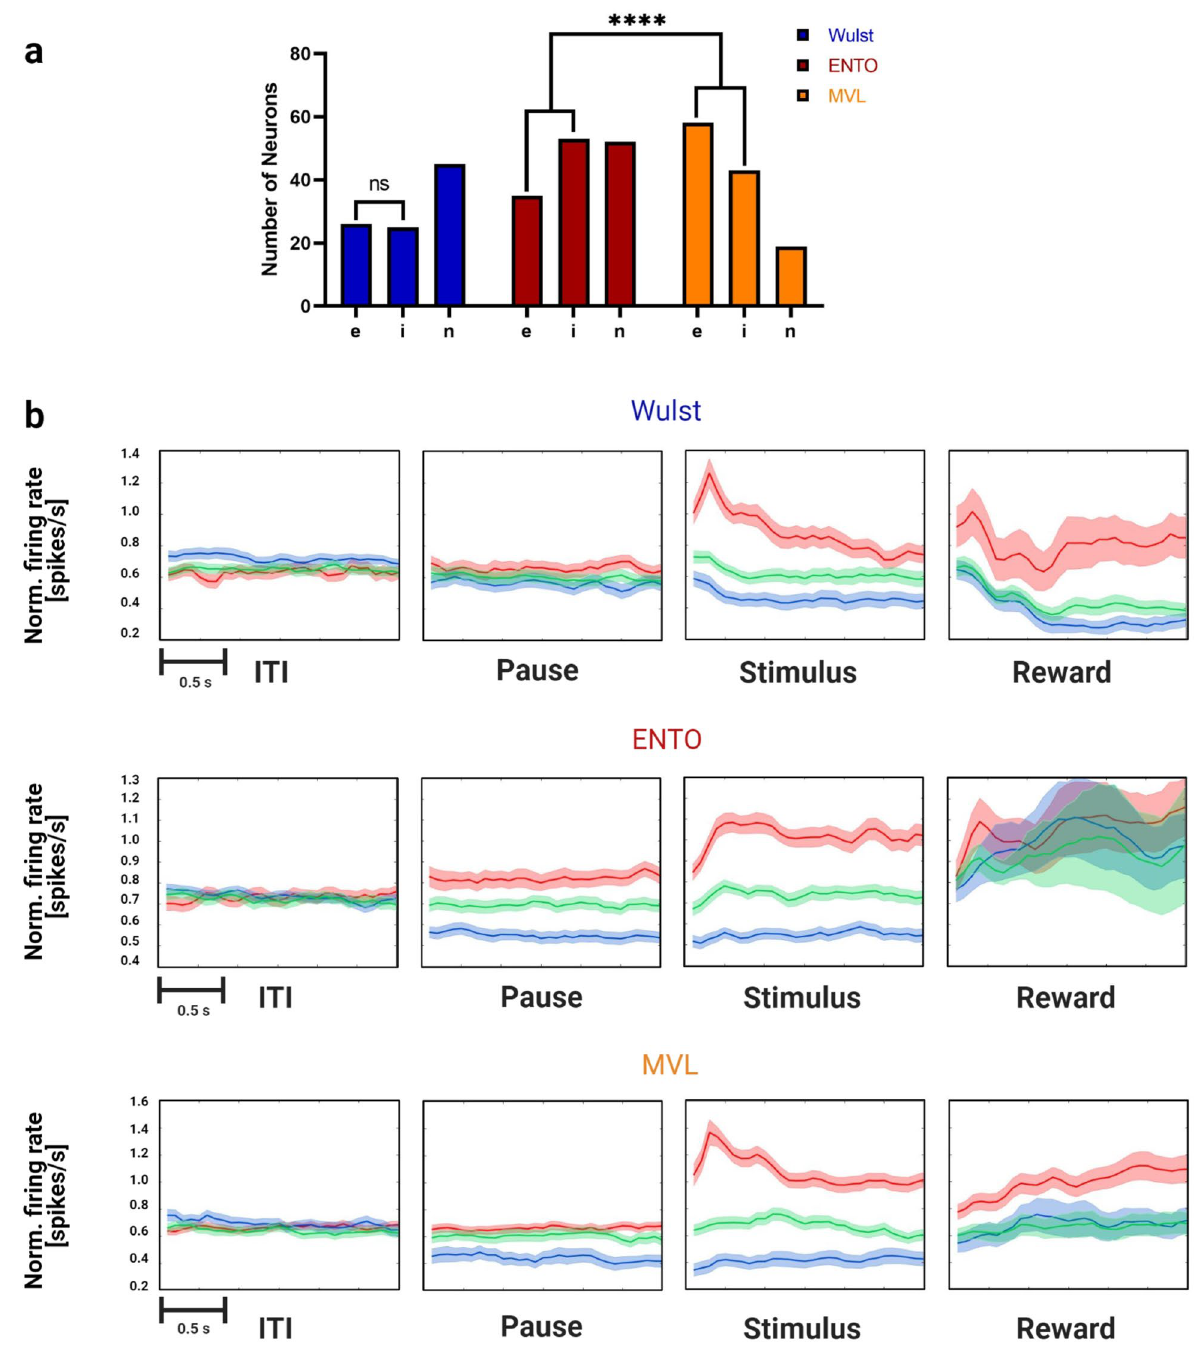
Figure 3. Single neuron response characteristics of Wulst, ENTO and MVL. ( a ) Totals of individual neurons that displayed excitatory (e) and inhibitory (i) responses to the visual stimuli, and totals that were non-responsive (n) to visual stimulation. Asterisks represent significant differences between regions for the relative proportions of visually-responsive/stimulus-selective neurons, and excitatory/inhibitory neurons: **** p < 0.00001. ( b ) Plots of normalised firing rate across each experimental period, calculated for excitatory (red), inhibitory (blue) and non-visually-responsive (green) neurons in Wulst, ENTO and during the pause period. The relative proportion of visually-responsive neurons that became active during the pause period was substantially greater in ENTO relative to MVL ( χ 2 (1) = 7.05, p = 0.007), but not in ENTO relative to Wulst ( χ 2 (1) = 2.55, p = 0.11). The increased responsivity of ENTO during the pause period suggests that visually-responsive neurons may be modulated to a greater extent by attentional processes in anticipation of the upcoming visual stimulus in ENTO than at the level of MVL.